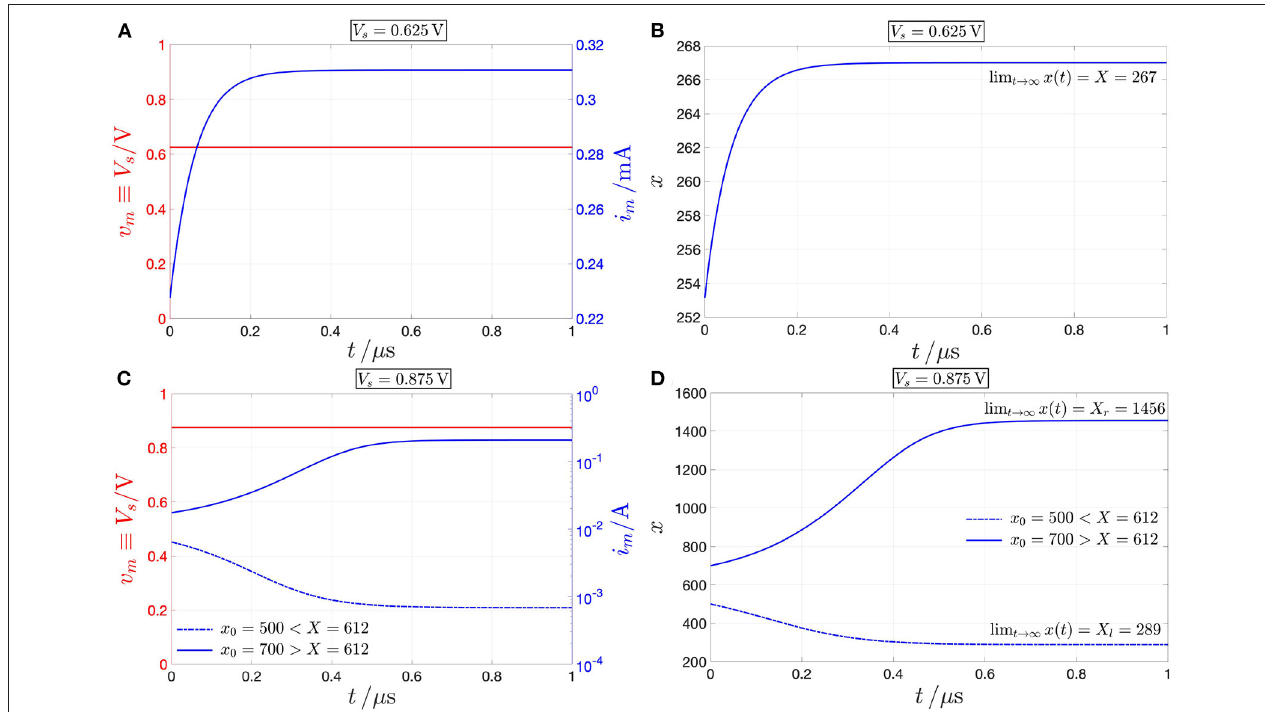
FIGURE 6 | Response of the NbO threshold switch to the application of an independent source of DC voltage V s between its two terminals. (A) Memristor current (blue) under DC voltage stress with V s 0.625V (red). Here, the load line—refer to the vertical blue line in Figure 5A —intersects the memristor DC locus in the lower = PDR branch. (B) Time waveform of the memristor state, converging to the globally asymptotically stable value X waveform: Current through the NbO micro-structure under DC voltage stress with V s memristor operating state X 612, constituting the separatrix between the basins of attraction of the two-locally stable bias memory states X l = (recall Figure 4) . Here the load line—refer to the vertical red line in Figure 5B —crosses the memristor DC characteristic in the NDR region, where the unstable operating point lies, as well as in either of the two PDR regions, where the threshold switch may be found asymptotically. (D) Dash-dotted (solid) blue solution: Time evolution of the memristor state, converging to the locally asymptotically stable value X l